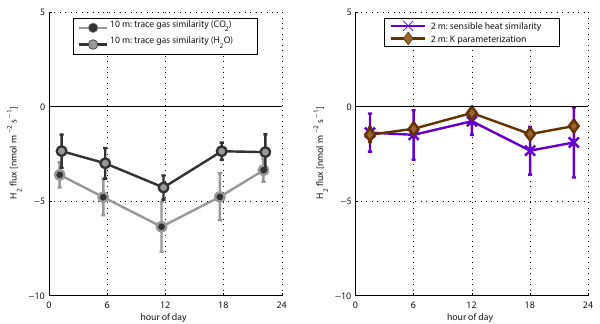
Figure 11. Comparison of wintertime (1–14 February 2012) H 2 fluxes above (left) and below (right) the canopy determined by trace gas similarity via CO 2 and H 2 O, K parameterization, and sensible heat similarity in the winter. Data points represent 6h aggregate mean and 95% confidence